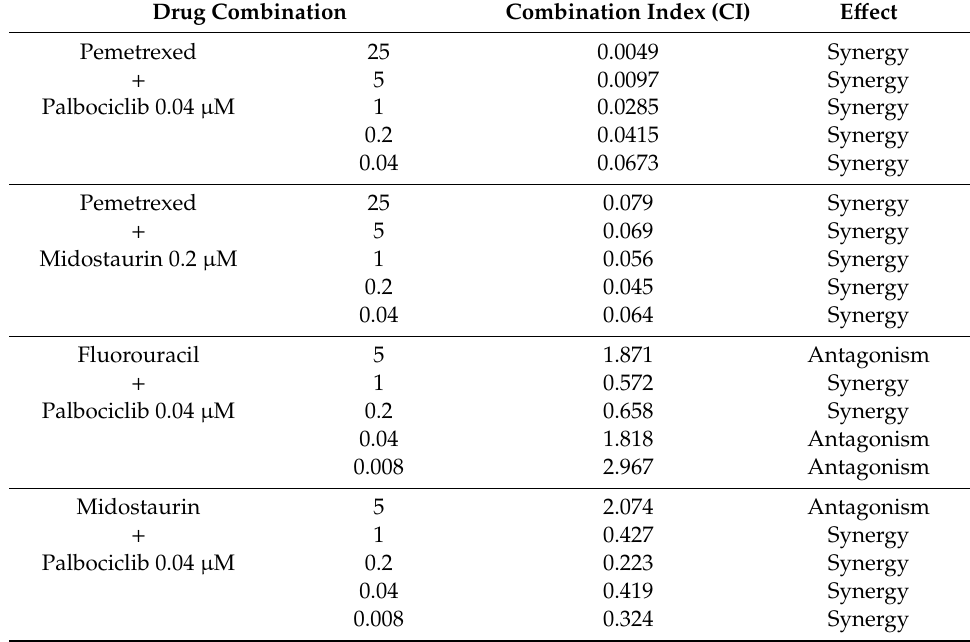
Table 2. Combination index values for pemetrexed and fluorouracil combinations with palbociclib and midostaurin. Macrophages were treated with the di ff erent at indicated concentrations in combination with 0.04 µ M of palbociclib or 0.2 µ M of midostaurin and infected with HIV-1 for 48h. Drug e ffi cacy was analyzed by measuring inhibition of HIV-1 replication by flow cytometry. Drug Combination Combination Index (CI) E ff ect